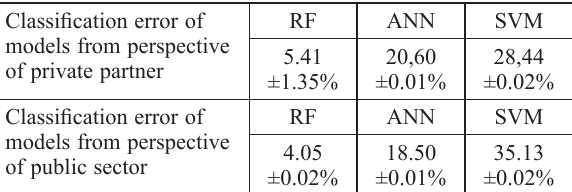
Table 3. PPP road infrastructure projects’ effectiveness modelling Classification error of models from perspective of private partner